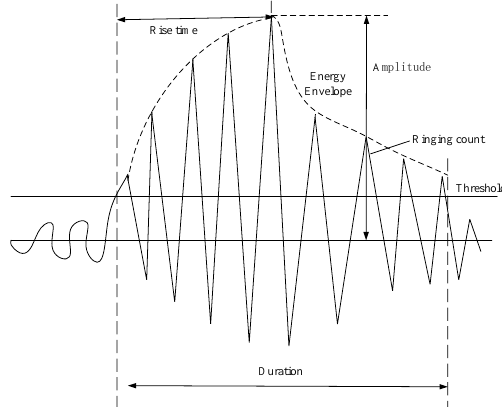
Figure 1. Acoustic emission simplified waveform characteristic parameter model.